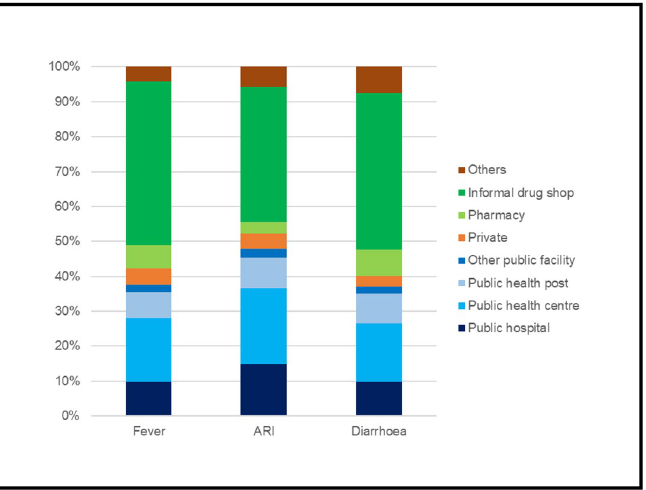
Fig 3. Sources where care was sought by caregivers of children under five with fever, ARI symptoms and diarrhoea in Nigeria (2018).